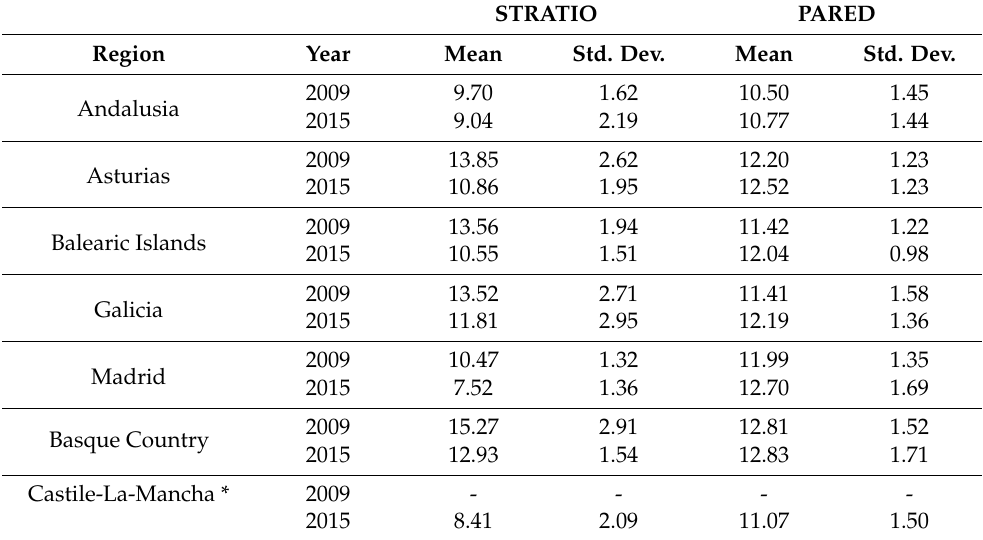
Table 2. Mean and standard deviation of STRATIO and PARED inputs in public schools by year and region. STRATIO PARED Region Year Mean Std. Dev. Mean Std. Dev. Andalusia